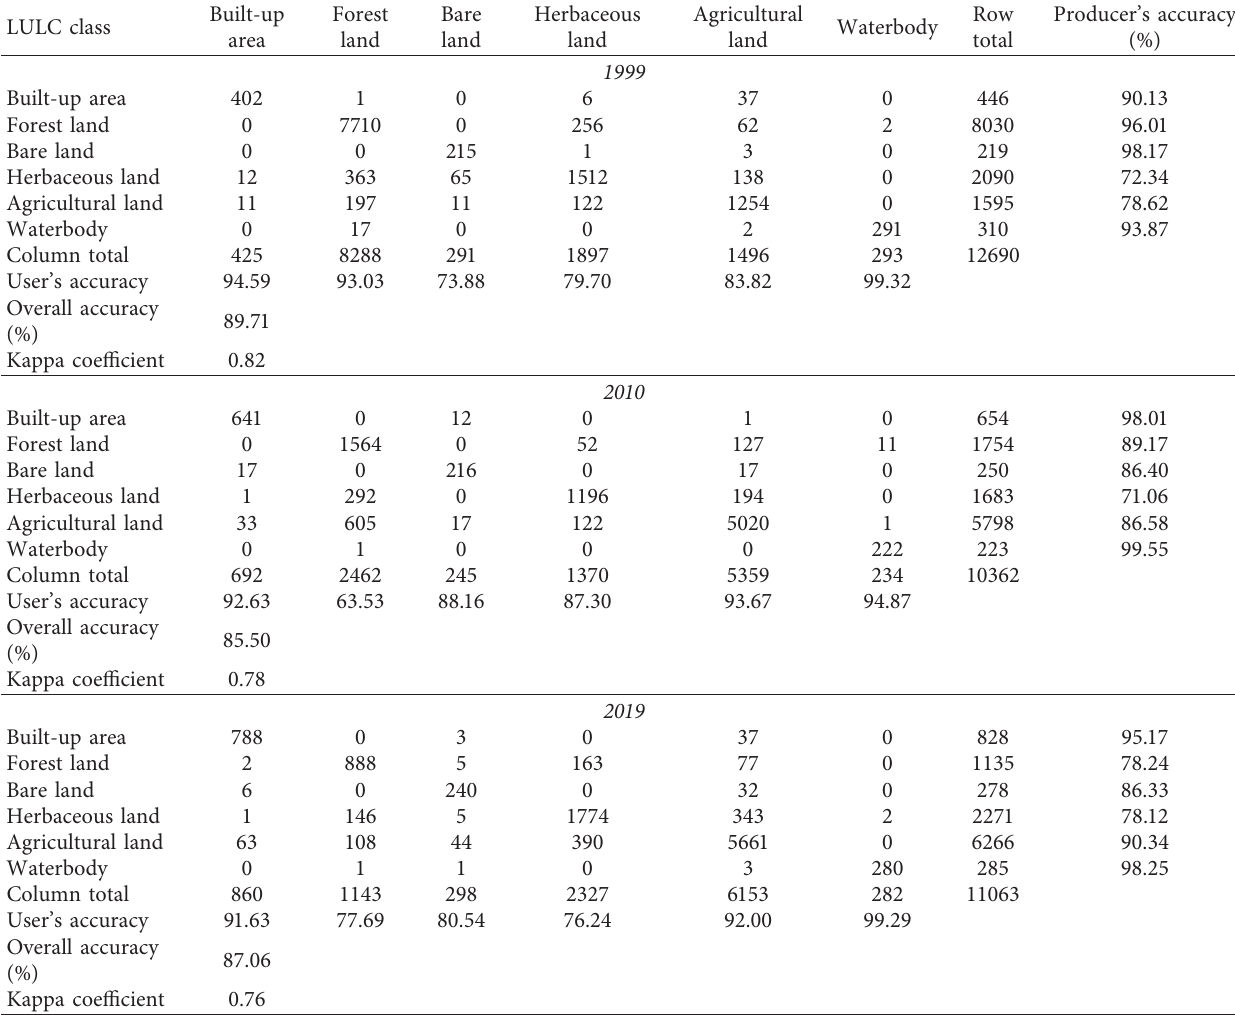
Table 3: Error matrix: accuracy assessment for land cover maps of 1999, 2010, and